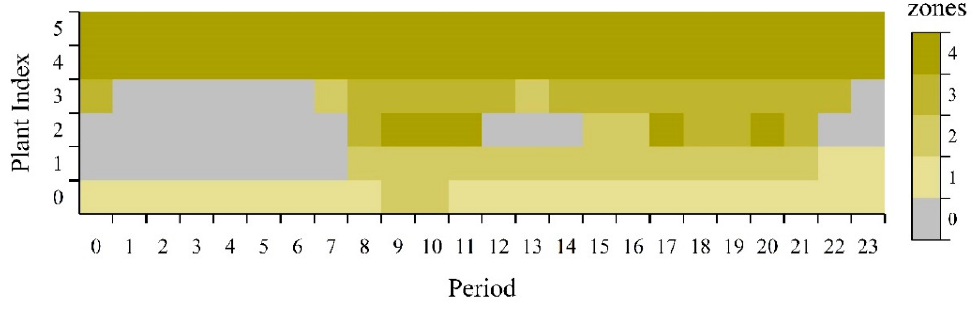
Figure 8. Hourly operating zones of plants.